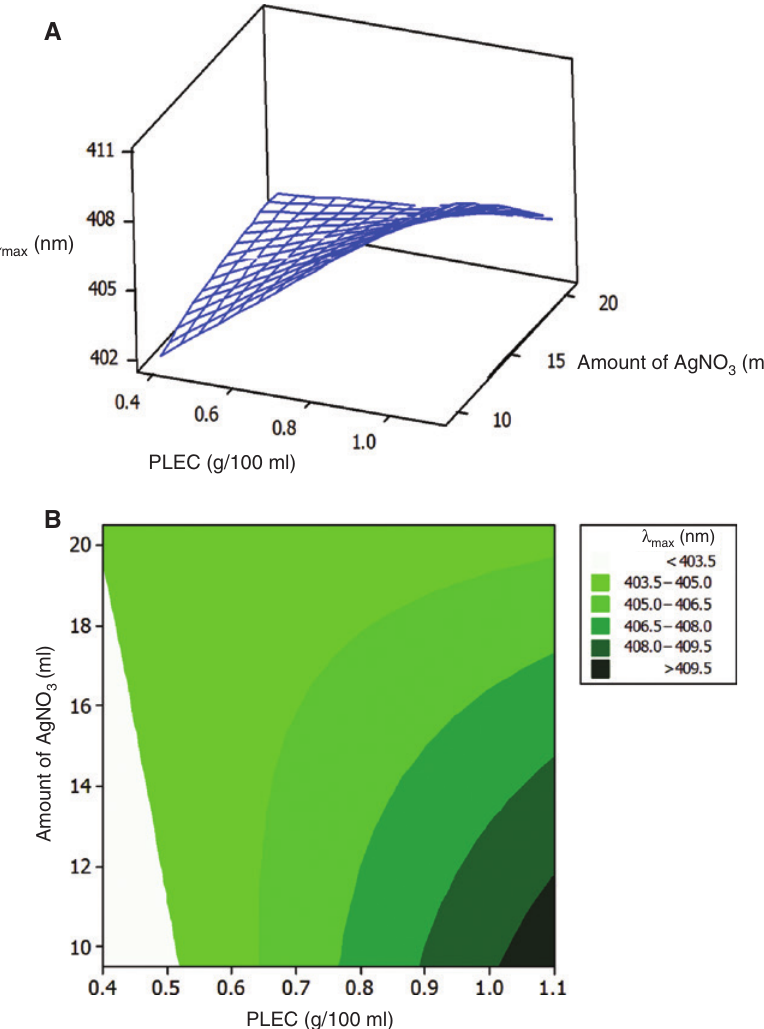
of the synthesized AgNP solution as a function of the amount of AgNO max